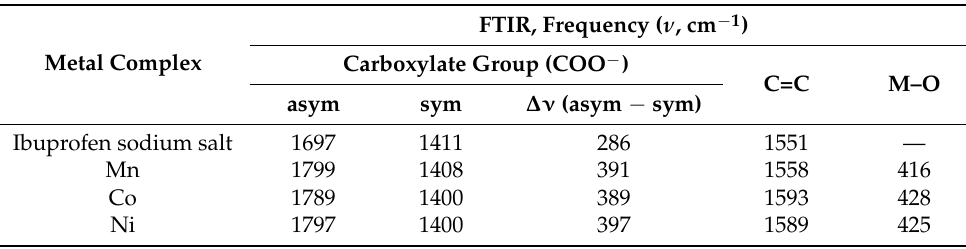
of the synthesized complexes are shown in Figures S1–S3. Table 2. FTIR spectral data for the ligand in the ibuprofen sodium salt and metal complexes ob ‐ Table 2. FTIR spectral data for the ligand in the ibuprofen sodium salt and metal complexes ob ‐ tained according to Scheme 1. Table 2. FTIR spectral data for the ligand in the ibuprofen sodium salt and metal complexes ob ‐ tained according to Scheme 1. Table 2. FTIR spectral data for the ligand in the ibuprofen sodium salt and metal complexes ob ‐ tained according to Scheme 1. tained according to Scheme 1. Table 2. FTIR spectral data for the ligand in the ibuprofen sodium salt and metal complexes obtained Table 2. FTIR spectral data for the ligand in the ibuprofen sodium salt and metal complexes ob ‐ Table 2. FTIR spectral data for the ligand in the ibuprofen sodium salt and metal complexes ob ‐ according to Scheme 1. tained according to Scheme 1. tained according to Scheme 1. Table 2. FTIR spectral data for the ligand in the ibuprofen sodium salt and metal complexes ob ‐ Table 2. FTIR spectral data for the ligand in the ibuprofen sodium salt and metal complexes ob ‐ tained according to Scheme 1. The electronic spectral data of the ligand and metal complexes are shown in Table 3. tained according to Scheme 1.